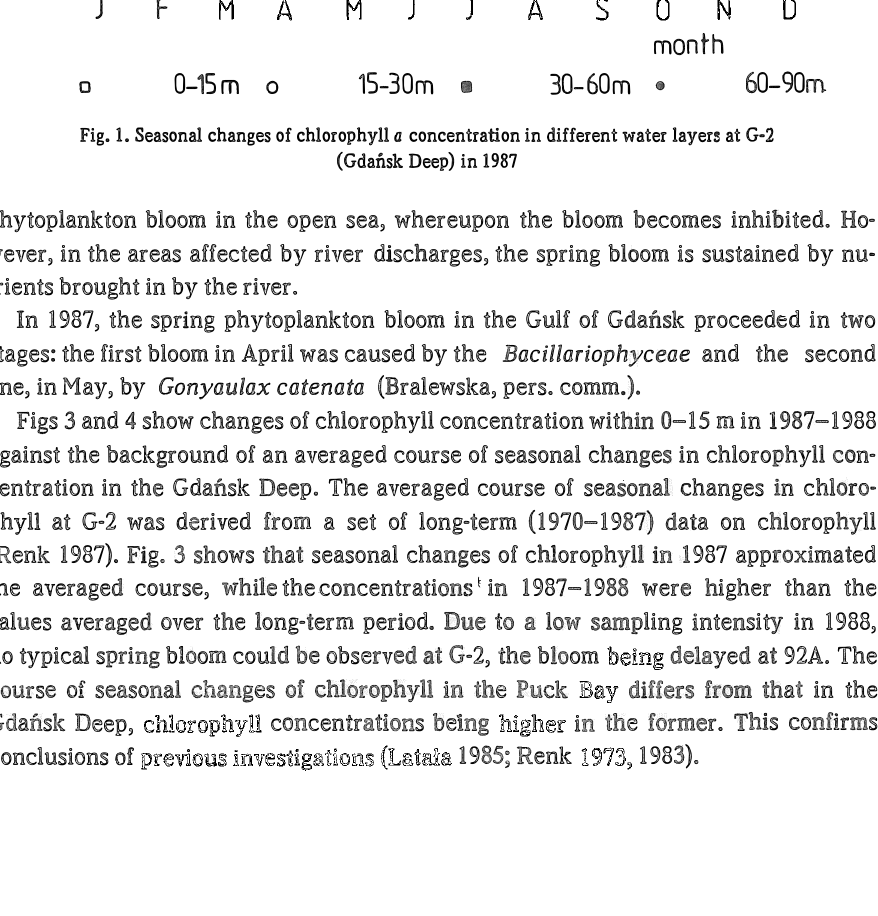
Fig. 1. Seasonal changes of chlorophyll a concentration in different water layer3 at G-2 (Gdaii.sk Deep) in